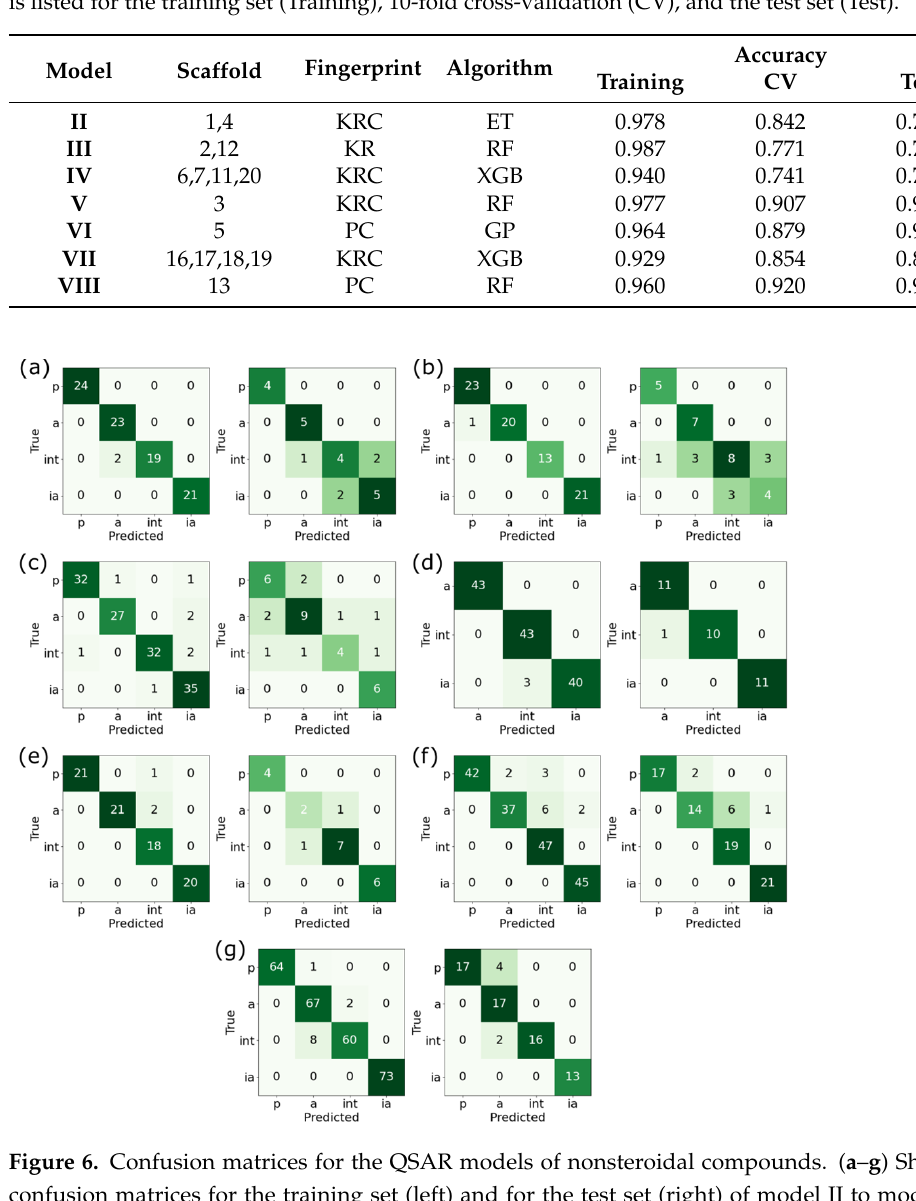
Table 6. Performance metrics for the QSAR classification models of seven groups of scaffolds. Each group contains scaffolds with the same cyclic skeleton. KRC, KR, and PC are the abbreviations for KlekotaRothCount, KlekotaRoth, and PubChem fingerprints, respectively. The accuracy performance